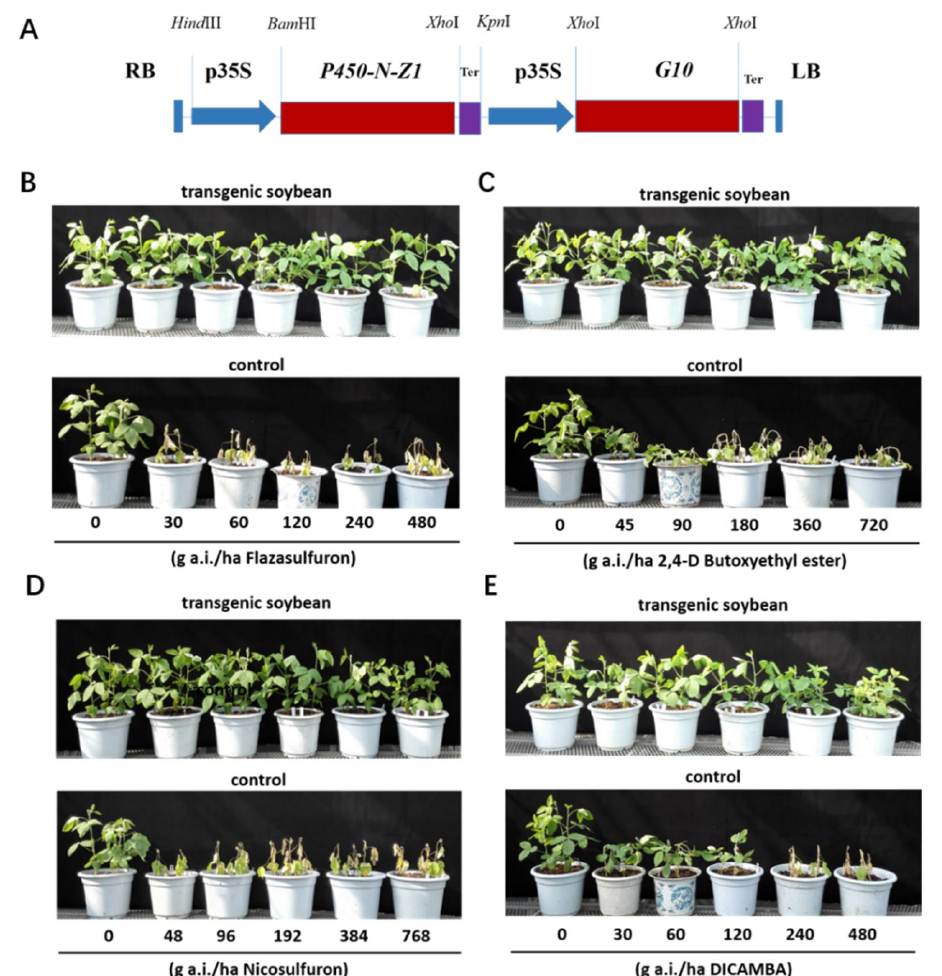
Figure 3. Herbicide tolerance assays of soybean expressing P450-N-Z1 . ( A ) The diagram of the T-DNA for transformation. ( B ) Transgenic soybean sprayed with flazasulfuron. ( C ) Transgenic soybean sprayed with 2,4-D. ( D ) Transgenic soybean sprayed with nicosulfuron. ( E ) Transgenic soybean sprayed with dicamba. For each herbicide, five different concentrations were applied to both transgenic plants (upper panel) and non ‐ transgenic plants (lower panel).